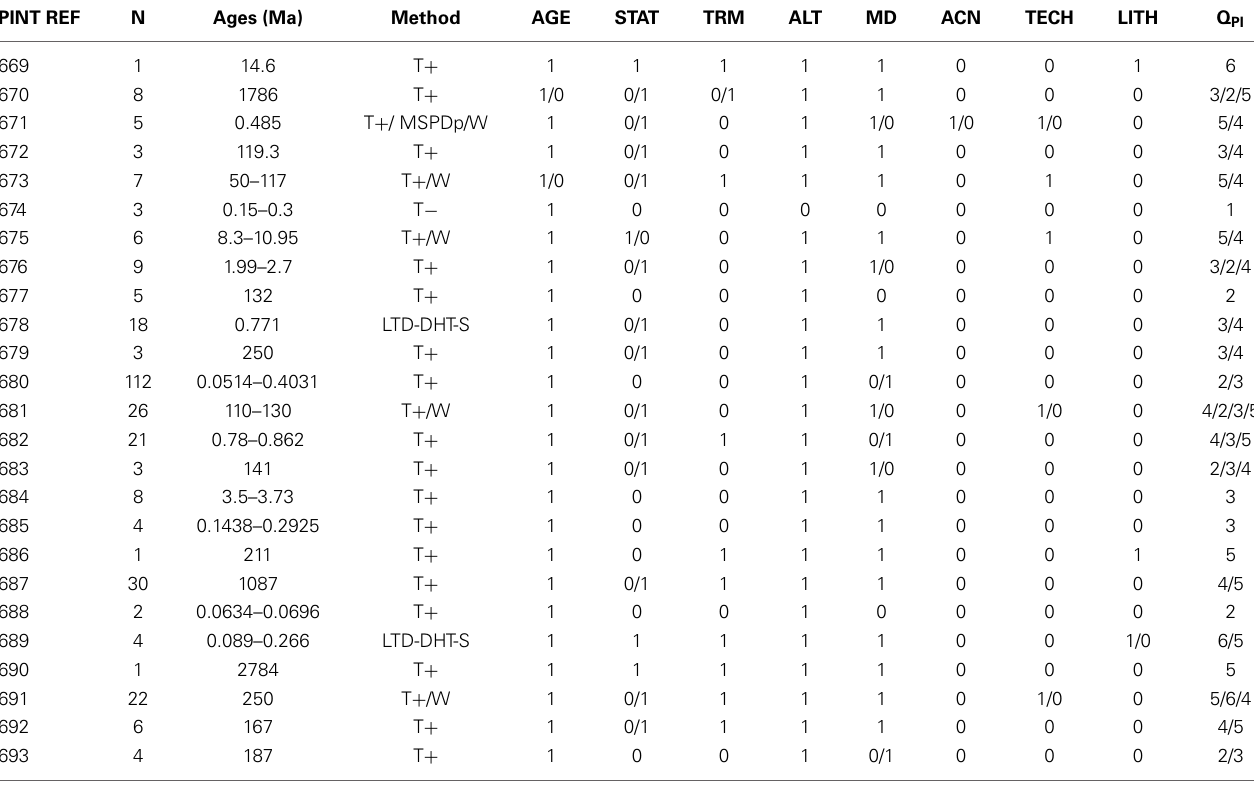
Table 2 | Breakdown of criteria fulfillment and Q PI values determined for results published in 25 studies recently added to the absolute palaeointensity (PINT)